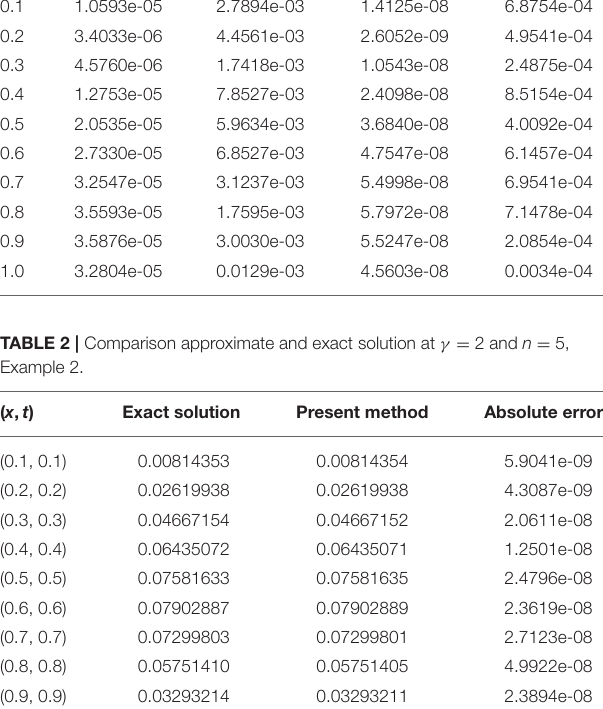
TABLE 1 | Comparison of absolute errors by our method and the method in [26] at t = 1, Example 2. x n = 3 n = 5 Present method Method in [26] Present method Method in [26] 0.0